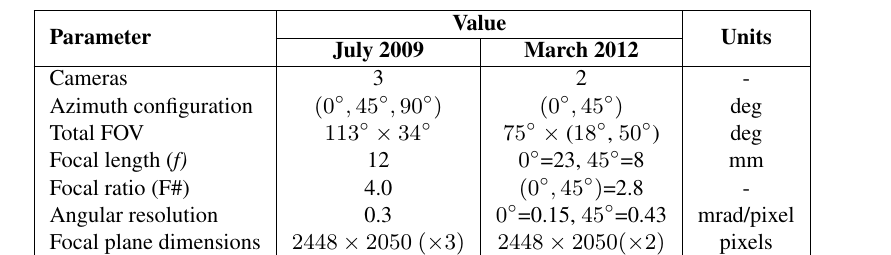
Table 1: Benchmark Datasets from July 2009 and March 2012